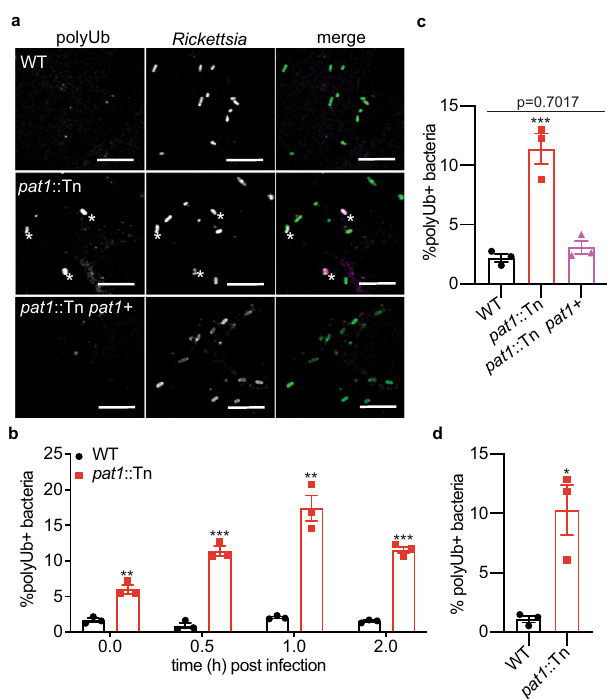
Fig. 3 Pat1 contributes to avoidance of polyubiquitin recruitment. a Images of polyubiquitin (polyUb; magenta in merge) in HMECs infected with WT, pat1 ::Tn, and pat1 ::Tn pat1 + bacteria (green in merge) at 1 hpi. Asterisk denotes colocalization between bacterium and polyUb. Scale bar 5 µ m. b Quanti fi cation of ( a ), percentage of polyUb-positive bacteria at the indicated time points (>1000 bacteria counted per strain/time point), MOI 3. Data are mean ± SEM; *** p = 0.00016 (0.5 hpi), p = 0.00003 (2 hpi), ** p = 0.00281 (0 hpi), p = 0.00105 (1 hpi) relative to WT (unpaired t -test, two-tailed). c Percentage of polyUb-positive bacteria in HMECs infected with WT, pat1 ::Tn, or complemented mutant ( pat1 ::Tn pat1 + ) at 1 hpi, MOI 3 (>1000 bacteria counted per strain). Data are mean ± SEM; *** p = 0.0005 relative to WT (one-way ANOVA with Dunnett ’ s post hoc test). d Percentage of polyUb-positive bacteria at 1 hpi in BMDMs (>1000 bacteria counted per strain), MOI 5. Data are mean ± SEM; * p = 0.0126 relative to WT (unpaired t -test, two-tailed). All data represent n = 3 independent experiments. Source data are provided as a Source Data fi le.